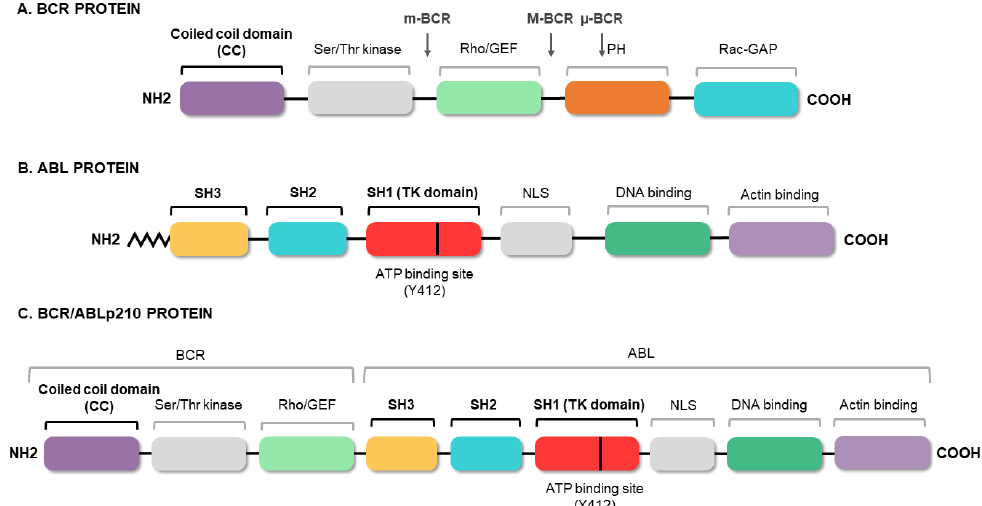
Figure 3. BCR / ABL protein domains. Protein regions located in the BCR ( A ) and ABL ( B ) proteins, and those maintained in the fusion ( C ). The figure highlights the coiled-coil (CC) domain of BCR , which allows the dimerization of the oncoprotein, and the three SRC domains of ABL1 , including the tyrosine kinase domain (SH1) and the regulatory domains (SH2 and SH3).